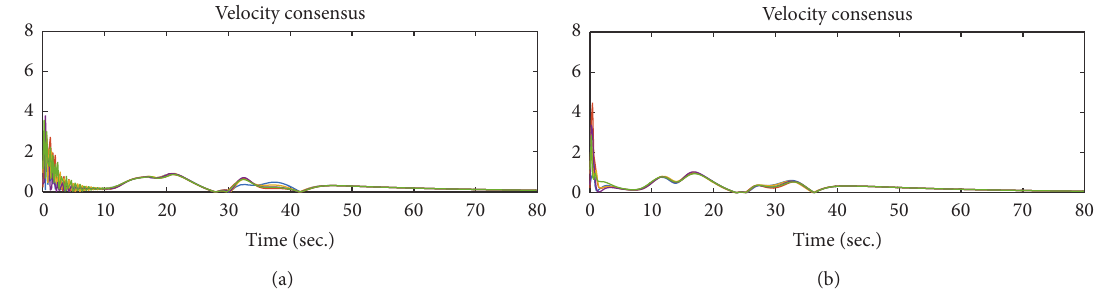
Figure 12: Multiagent velocity with multiple obstacles scenario. (a) Without 𝜆 2 gradient. (b) With 𝜆 2 gradient.